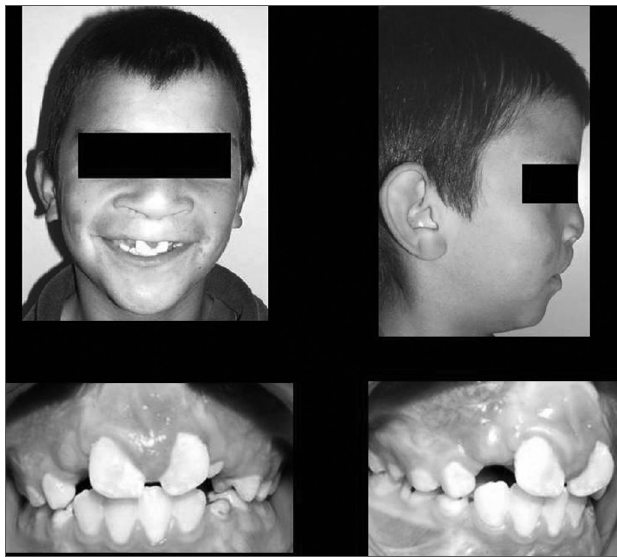
Table 3. Frequency distribution of the changes-perceived-after-treat- ment variable, in the total sample.